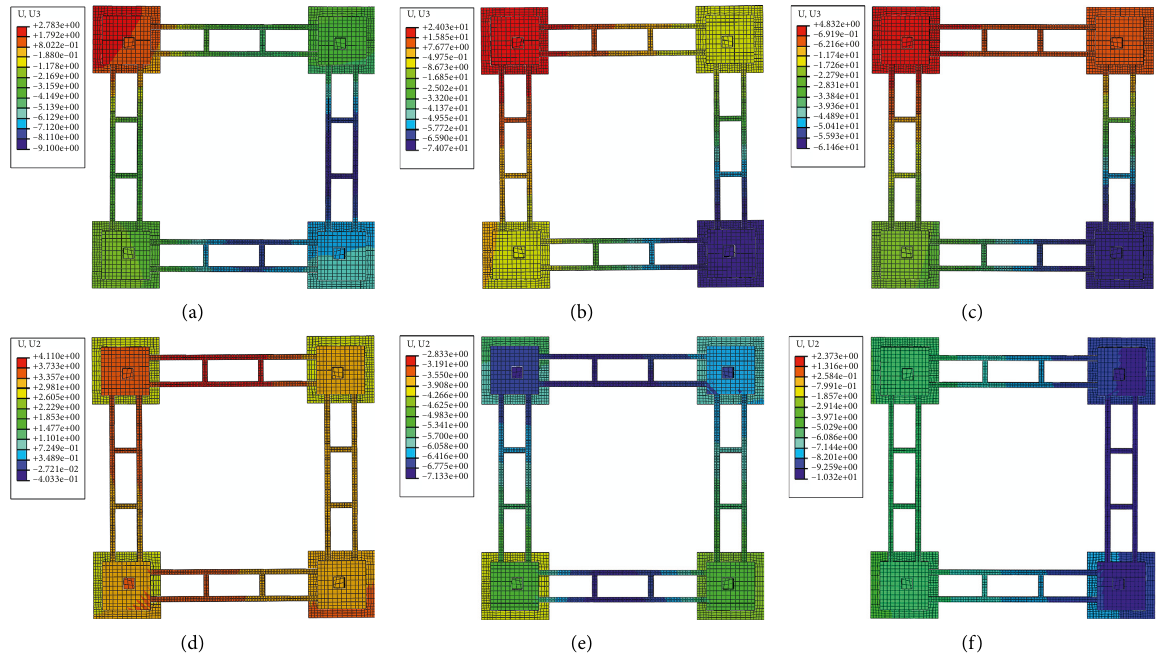
Figure 14: Displacement contrast diagram of cap: (a) homogeneous soil vertical displacement; (b) single foundation settlement vertical displacement; (c) double foundation settlement vertical displacement; (d) homogeneous soil horizontal displacement; (e) single foundation settlement horizontal displacement; (f) double foundation settlement horizontal displacement.